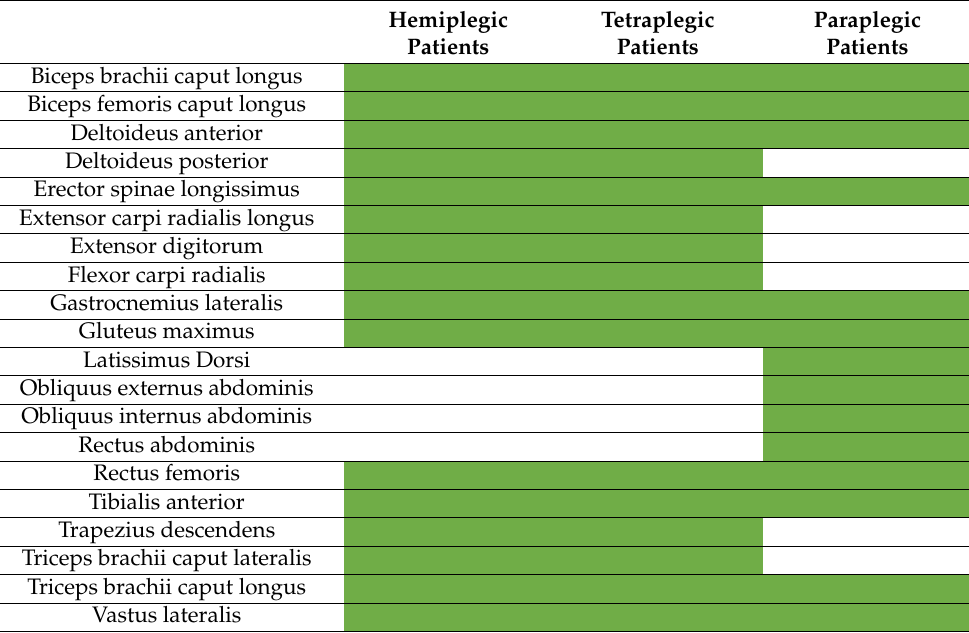
Table 3. List of muscles acquired for the patients’ groups. The green coloured squares indicate which muscles were registered for each group. On healthy controls, EMG was placed on all muscles to match patients’ data.